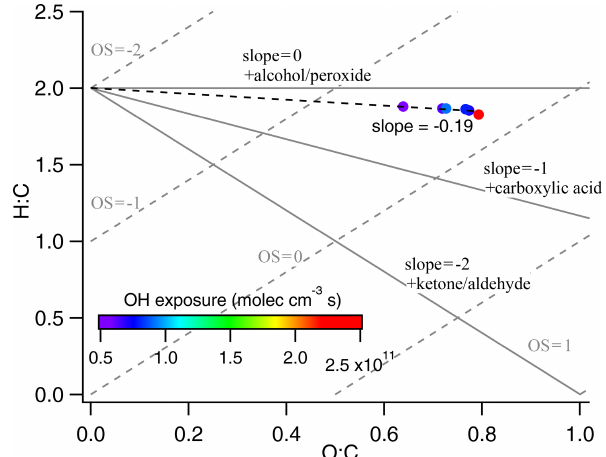
Figure 4. Van Krevelen diagram of canola oil SOA colored by dif- ferent OH exposure. In the background, average carbon oxidation state ( OSc) and functionalization slopes are shown for reference. The slope of − 0 . 19 for canola oil SOA corresponds to formation of both alcohol and carboxylic acid, consistent with the chemical composition obtained from